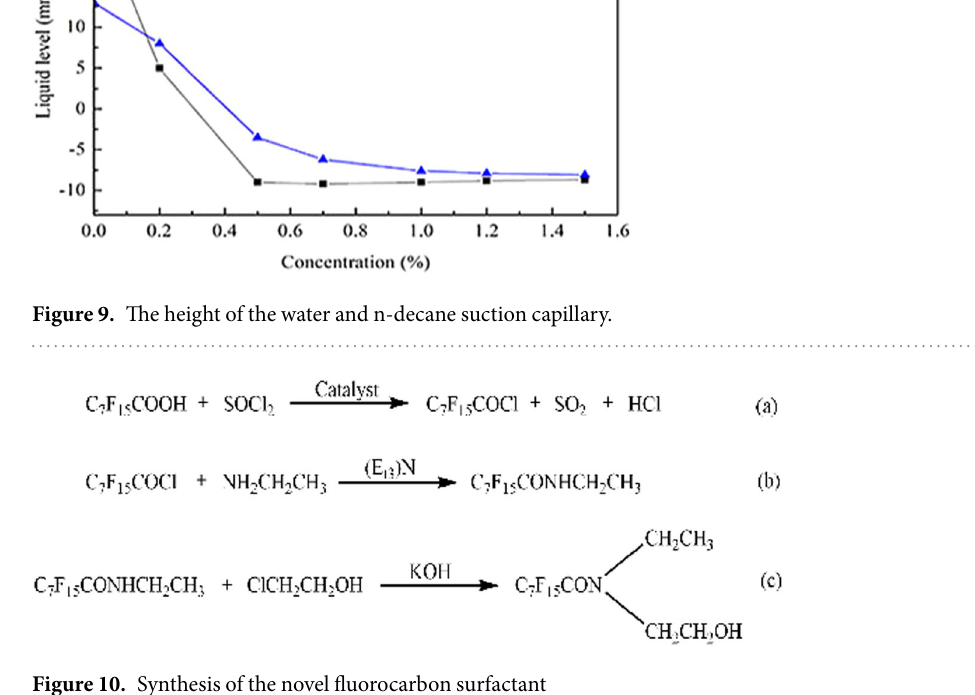
Figure 10. Synthesis of the novel fluorocarbon